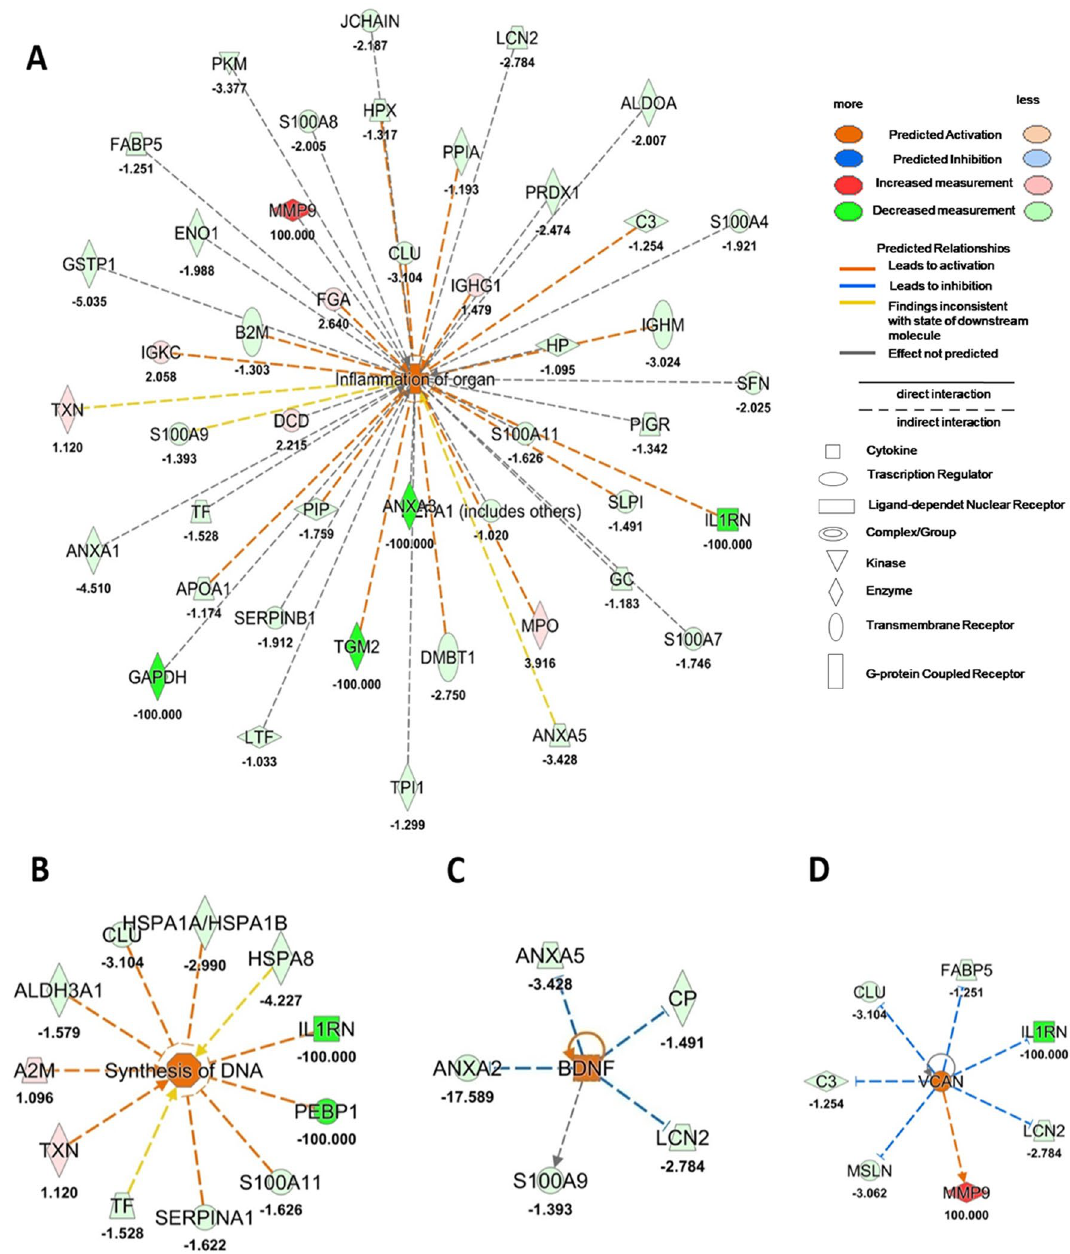
Figure 2. Tear functional proteomics results after 4 weeks of treatment. ( A , B ) Downstream analysis comparing proteomics dataset at T4 Vs T0 condition. The most significant downstream were: Inflammation of organ ( A ) and DNA synthesis ( B ). ( C , D ) reported the most significant upstream comparing proteomics dataset at T4 Vs T0 condition: Brain-derived neurotrophic factor (BDNF) ( C ) and Versican Core Protein (VCAN) ( D ). Orange or blue shapes represent predicted activation (z-scores ≥ 2.0) or predicted inhibition (z-scores ≤ 2.0), respectively. The color intensity is directly proportional to the significance of the predicted activation or inhibition. The predicted relationship between genes may lead to direct activation (orange solid lines) or direct inhibition (blue solid lines). Instead, red and green shapes represent increased or decreased measurements of identified proteins, respectively (whose fold change value is reported in the figure). Colour key and symbols are reported in the